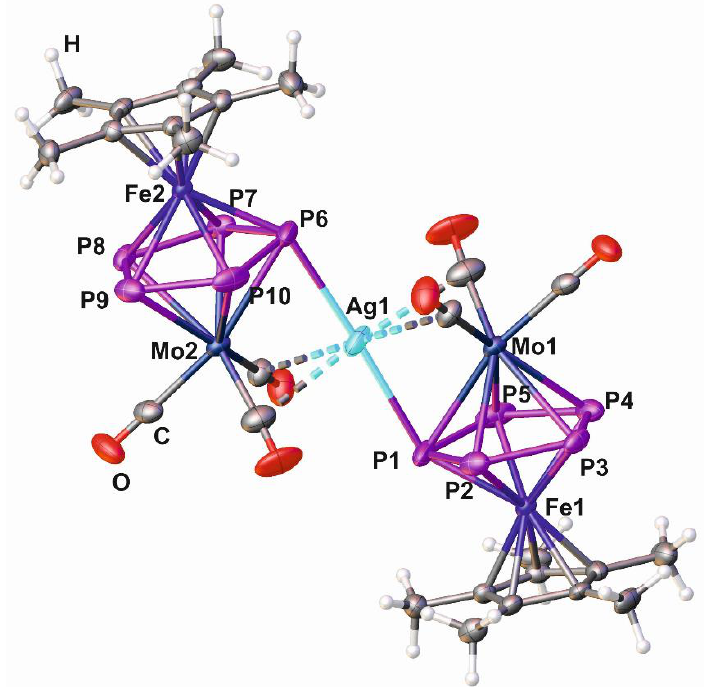
Figure 3. Molecular structure of the cation of 4 in the solid state. Selected bond lengths [Å ] and